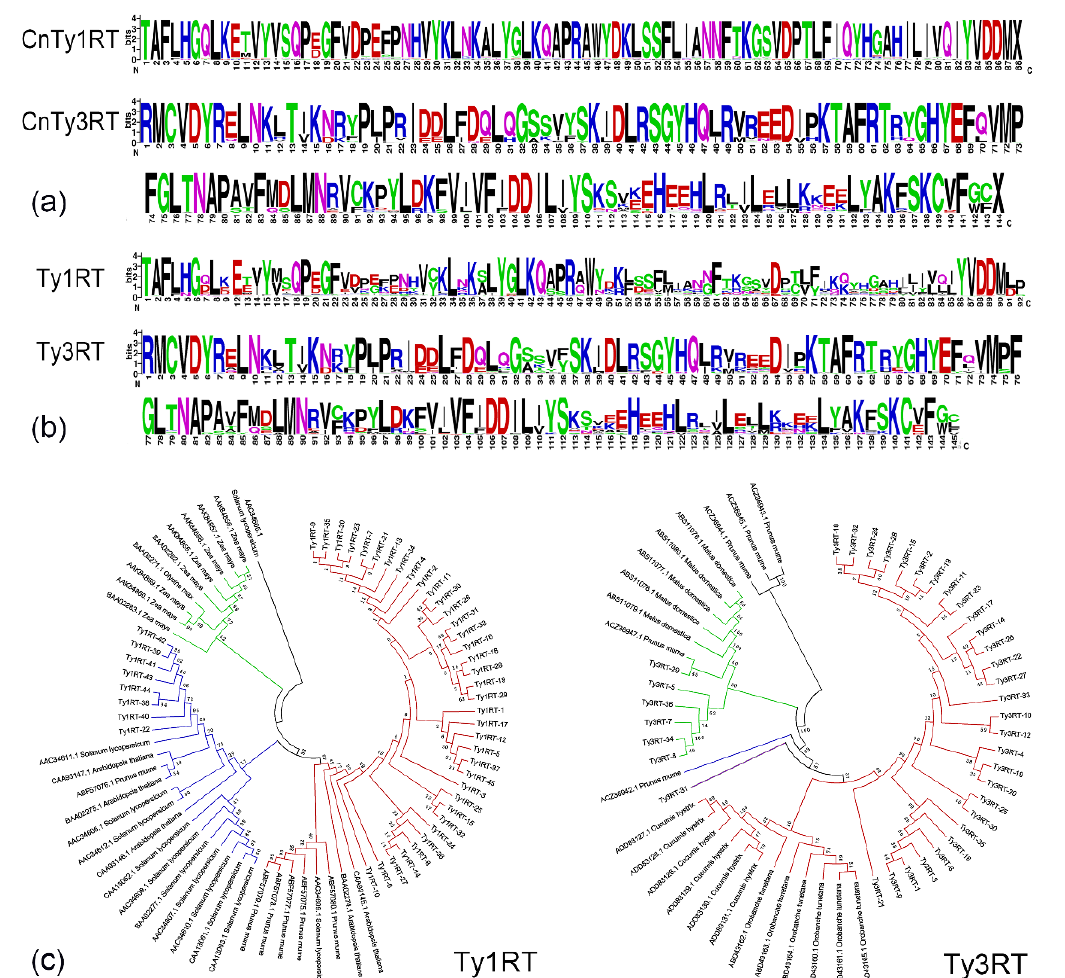
Figure 3. Amino acid analysis of the RT region of the LTR retrotransposon. ( a ) WebLogo plot of amino acid frequencies at conserved regions of Ty1RT and Ty3RT of C. nankingense . Positions are relative to the 5′ end of the target site. N, length of the target site. Logos were generated using WebLogo. ( b ) WebLogo plot of amino acid frequencies at conserved regions of the Ty1RT and Ty3RT sequences of different species. Positions are relative to the 5′ end of the target site. N, length of the target site. Logos were generated using WebLogo. ( c ) The phylogenies of Ty1RT and Ty3RT using neighbor-joining trees. According to the BlastX results, homologous sequences from other species were the most related sequences in the NCBI